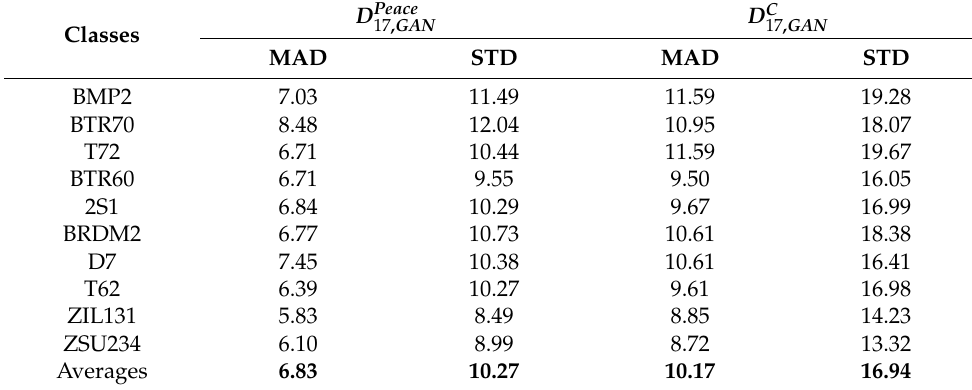
and D C . 17, GAN 17, GAN